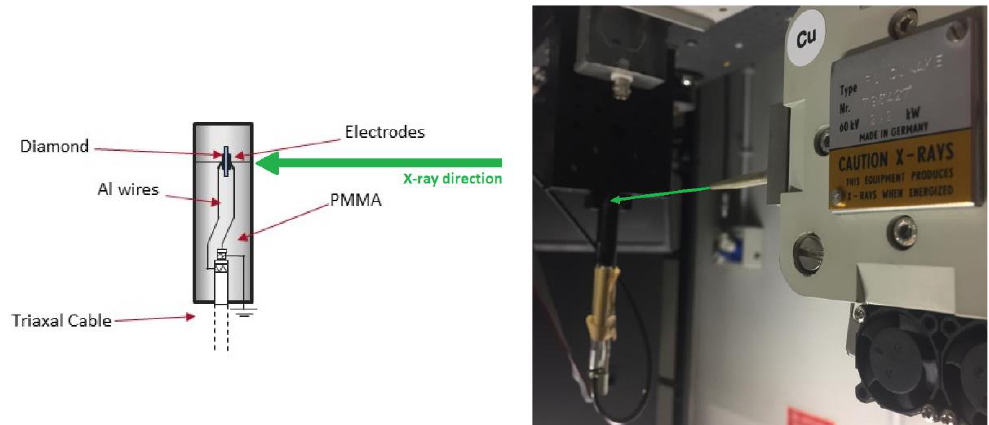
Figure 1. Cross-sectional scheme of the fabricated dosimeter ( left ); Setup of the characterization under continuous low-energy X-rays ( right ), showing on the right the Coolidge tube (Cu target) with the output collimator pointed towards the dosimeter. Green arrows indicate the direction of the X-ray beam focused on the active area of the dosimeter.